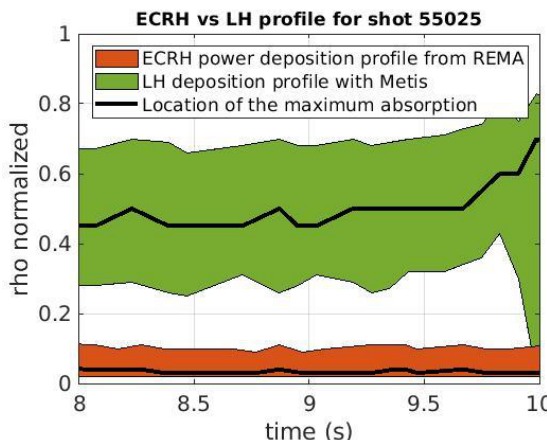
Figure 9: Evolution of LH and EC power deposition profiles in shot 55025 (colored areas: full width at half maximum of the deposition; black line: location of deposition